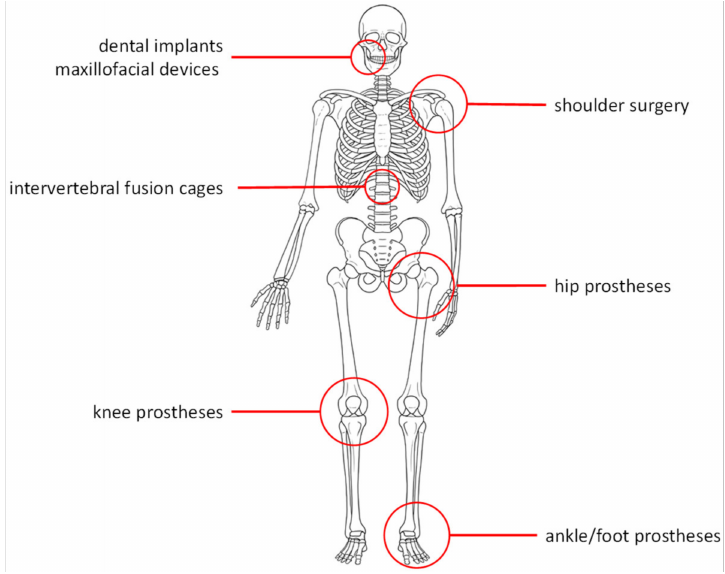
Figure 2. Tantalum devices for endosseous